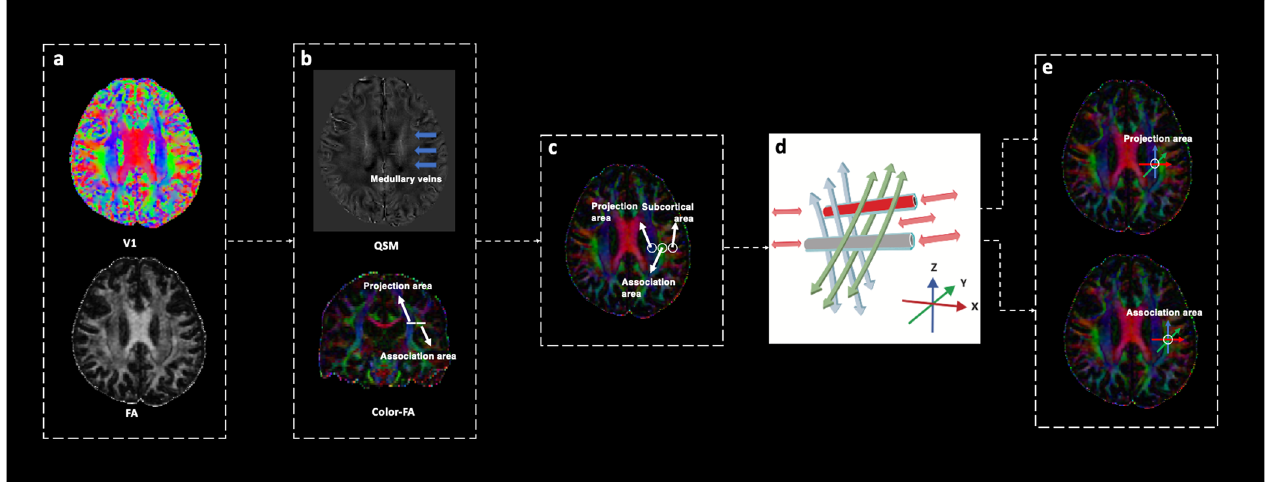
Fig. 4 Schematic drawing of the diffusivity measurement using the DTI-ALPS method. a Steps to get the colour-coded FA map. b Select a slice in which the direction of medullary veins runs perpendicular to the ventricle wall. c Colour-coded FA map showing the ROI regions of the projection fi bres (blue; z axis), association fi bres (green; y axis), and the subcortical fi bres (red; x axis). d Schematic indicating the relationship between the direction of the PVS (grey cylinders) and the fi bres (the direction of the PVS is perpendicular to both projection and association fi bres). e Placing two ROIs in the area of the projection fi bres (blue) and the area of the association fi bres